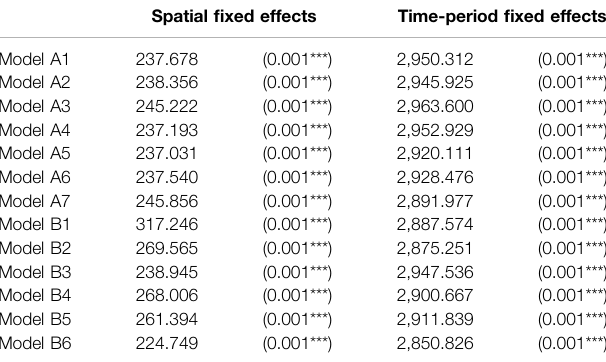
TABLE 3 | LR statistics in the spatial and time-period fi xed-effect